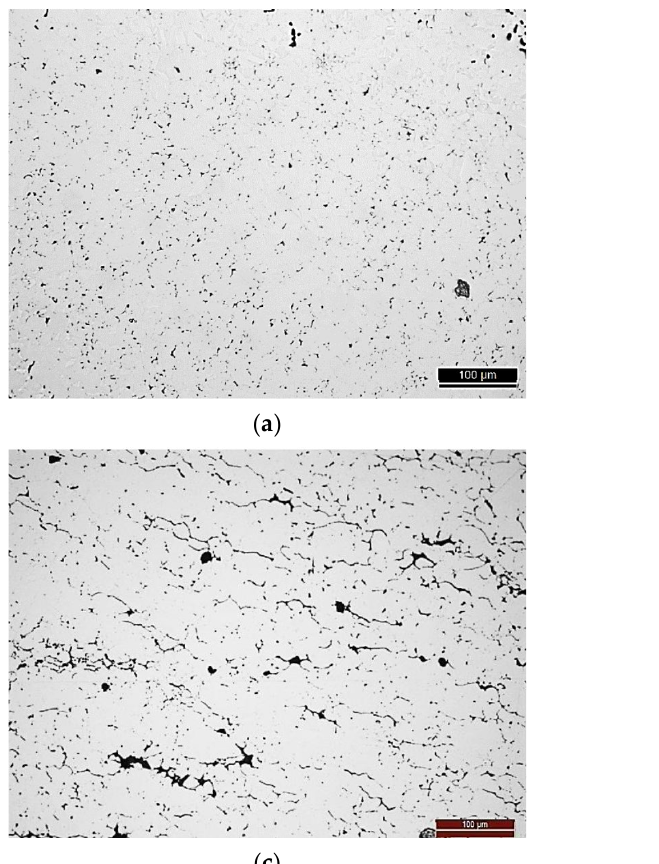
Figure 4. Grain size distributions of Ni and nanocomposites produced with 0.50, 0.75, and 1.00 vol.% of CNT heat-treated (HT) at 1100 °C for 30 min.